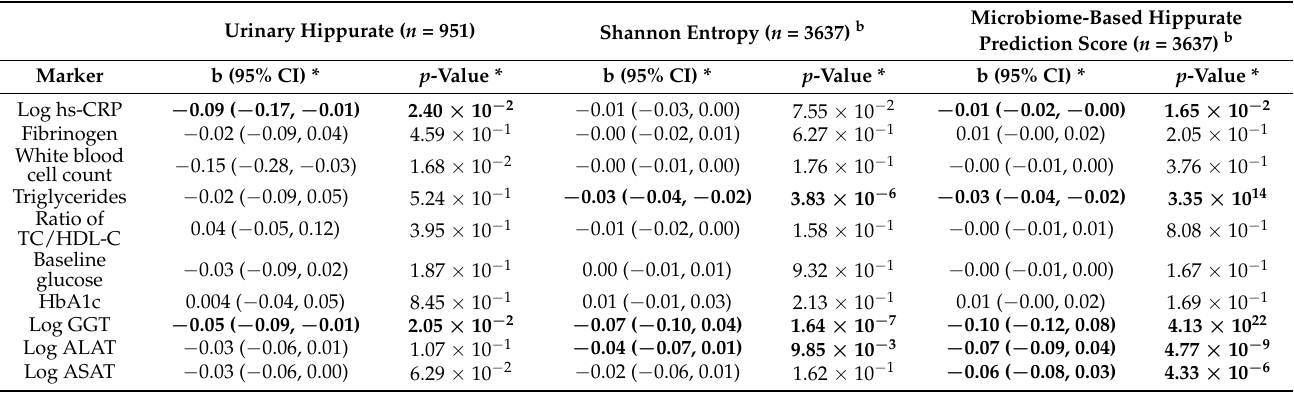
Table 2. Biomarker associations from multivariable regressions for urinary hippurate, Shannon entropy, and the microbiome-based hippurate prediction